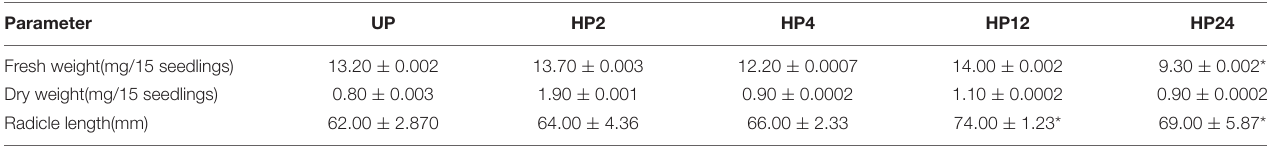
TABLE 3 | Results of phenotyping analyses performed on S. villosum seven-day old seedlings developed from seeds treated with hydropriming (HP2, HP4, HP12, and HP24) and unprimed (UP) seeds.